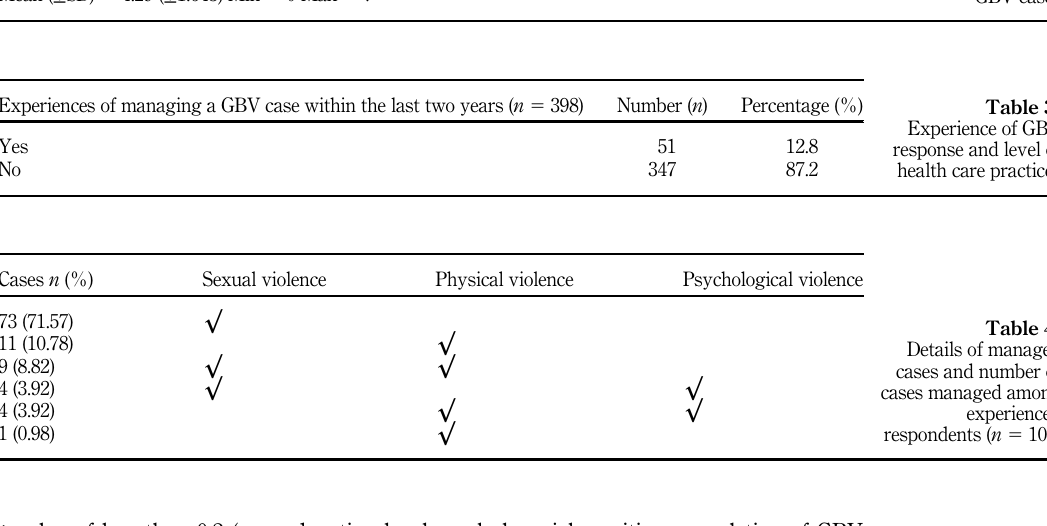
Table 2. Respondents by level